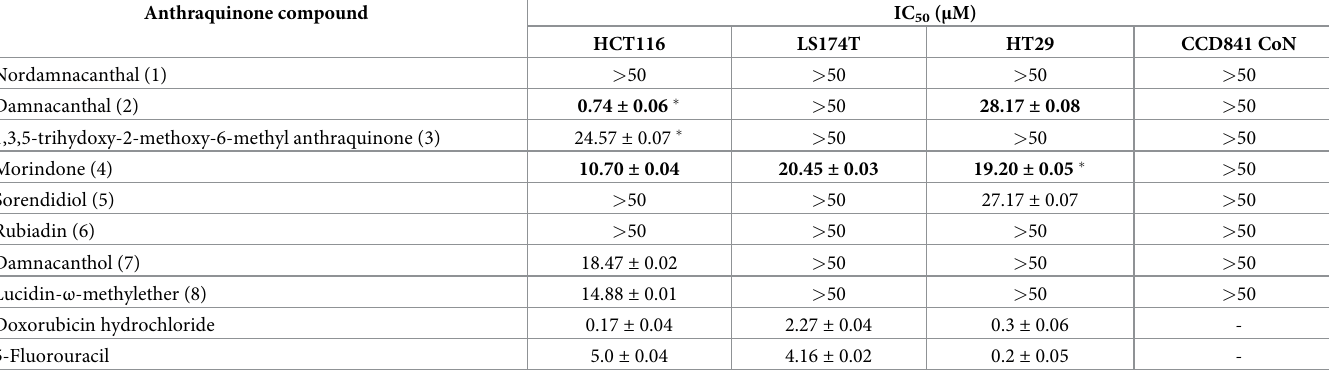
Table 2. IC 50 value of anthraquinone compounds 1–8, 5-Fluorouracil, doxorubicin hydrochloride in three colorectal cancer cell lines and normal colon cells.